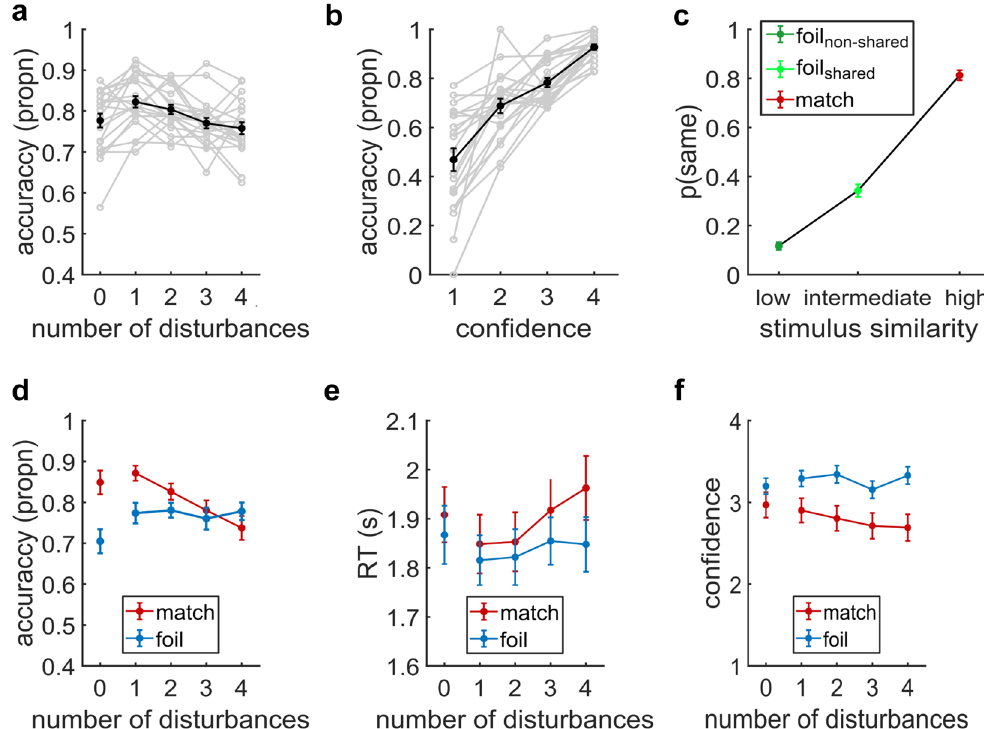
Figure 3. Experiment 1. ( a ) Recognition memory accuracy (proportion correct, propn) across the number of disturbances. ( b ) Accuracy for each confidence rating (1 = not confident, 4 = very confident). ( c ) Proportion of same responses for item probe pairs with different levels of stimulus similarity: highest in similarity (match), intermediate in similarity (foil pairs, shared component), lowest in similarity (foil pairs, non-shared component). ( d ) Recognition memory accuracy for match and foil trials across the number of disturbances. ( e ) RT (in seconds) averaged across the number of disturbances, separately for match and foil trials. ( f ) Confidence averaged across the number of disturbances, separately for match and foil trials. Data points are means, error bars are SEM. Gray lines represent single-subject data (N =